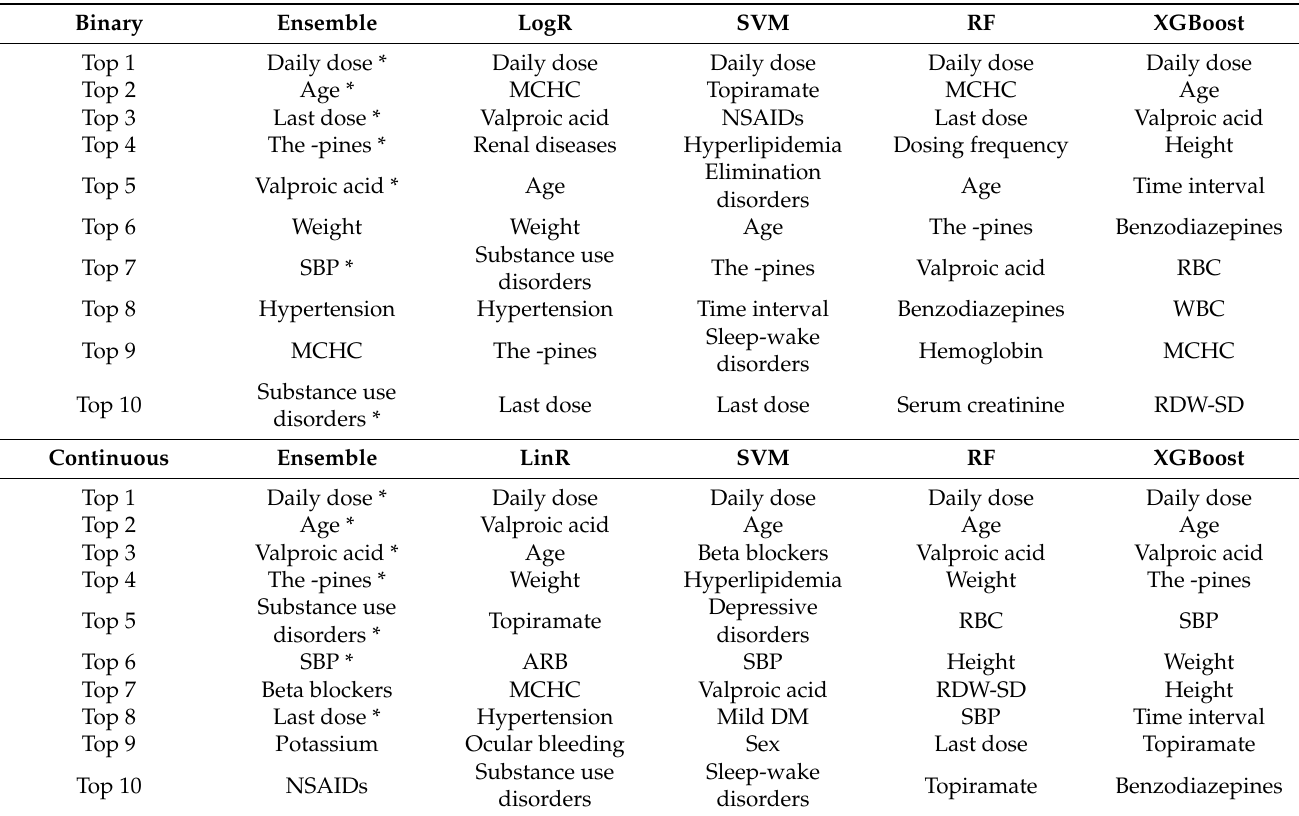
Table 3. Top 10 features of the binary and continuous outcomes between different